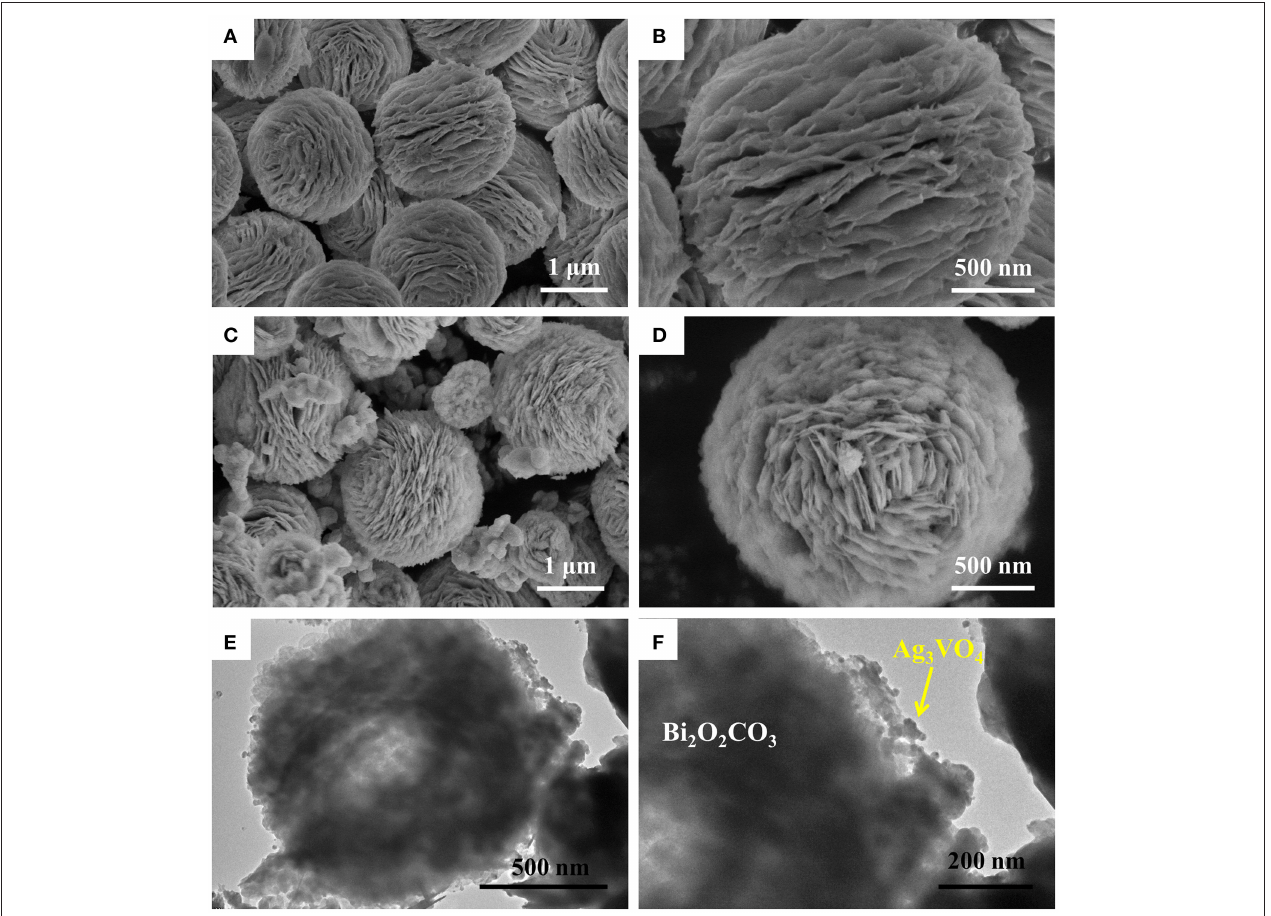
FIGURE 2 | SEM images of pristine Bi 2 O 2 CO 3 (A,B) and AVO/BOC-30 (C,D) ; TEM images of AVO/BOC-10 (E,F) .